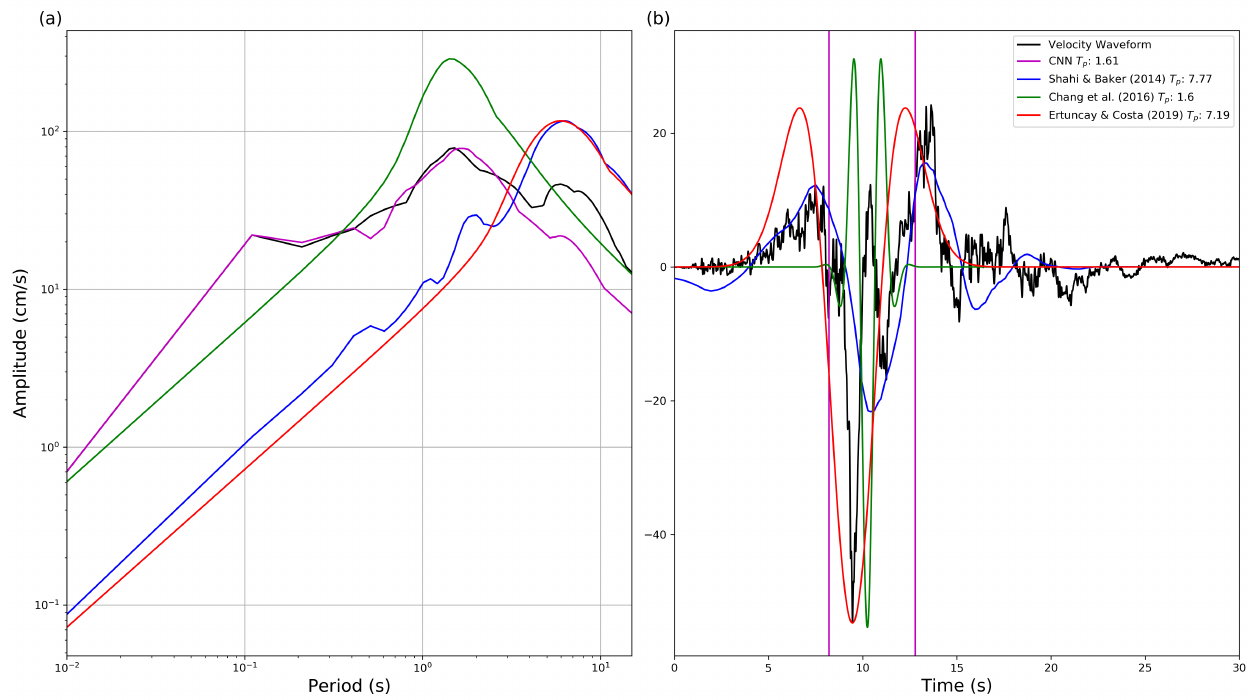
Figure 6. ( a ) Spectral response and ( b ) velocity waveform of the 28th of June 1992 Landers, USA earthquake ( M w = 7.3) recorded at Lucerne station ( R jb = 2.2km) along with fitted waveforms and their spectral responses of previous studies. Color and T p information are the same as in Figure